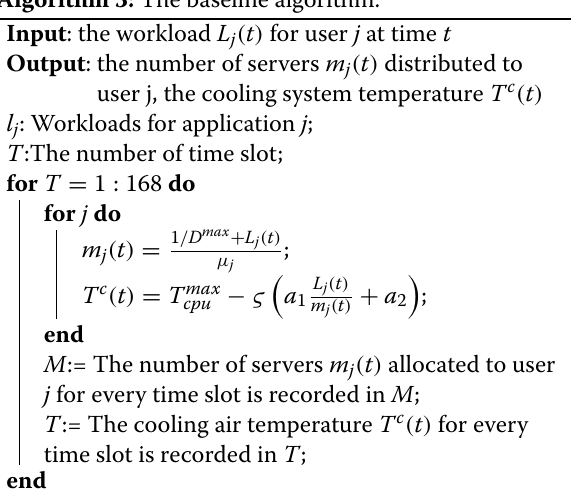
Algorithm 3: The baseline